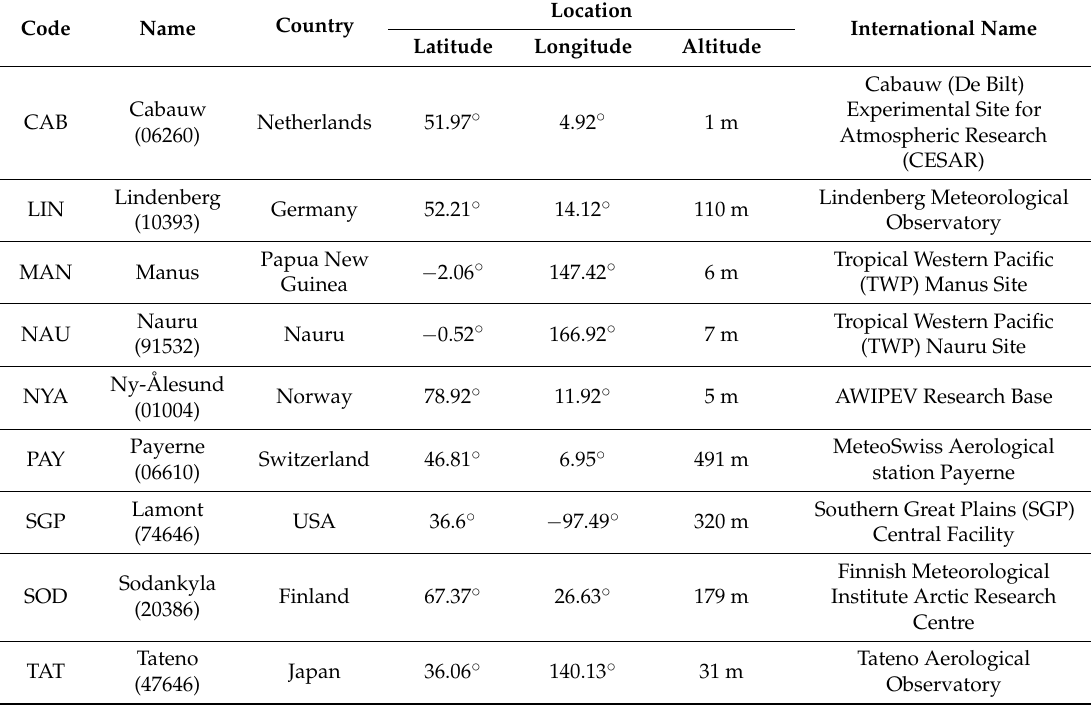
Table 1. Information on the Global Climate Observing System Reference Upper-Air Network (GRUAN) radiosonde sites used in this study. Numbers given with names are WMO station numbers used for the